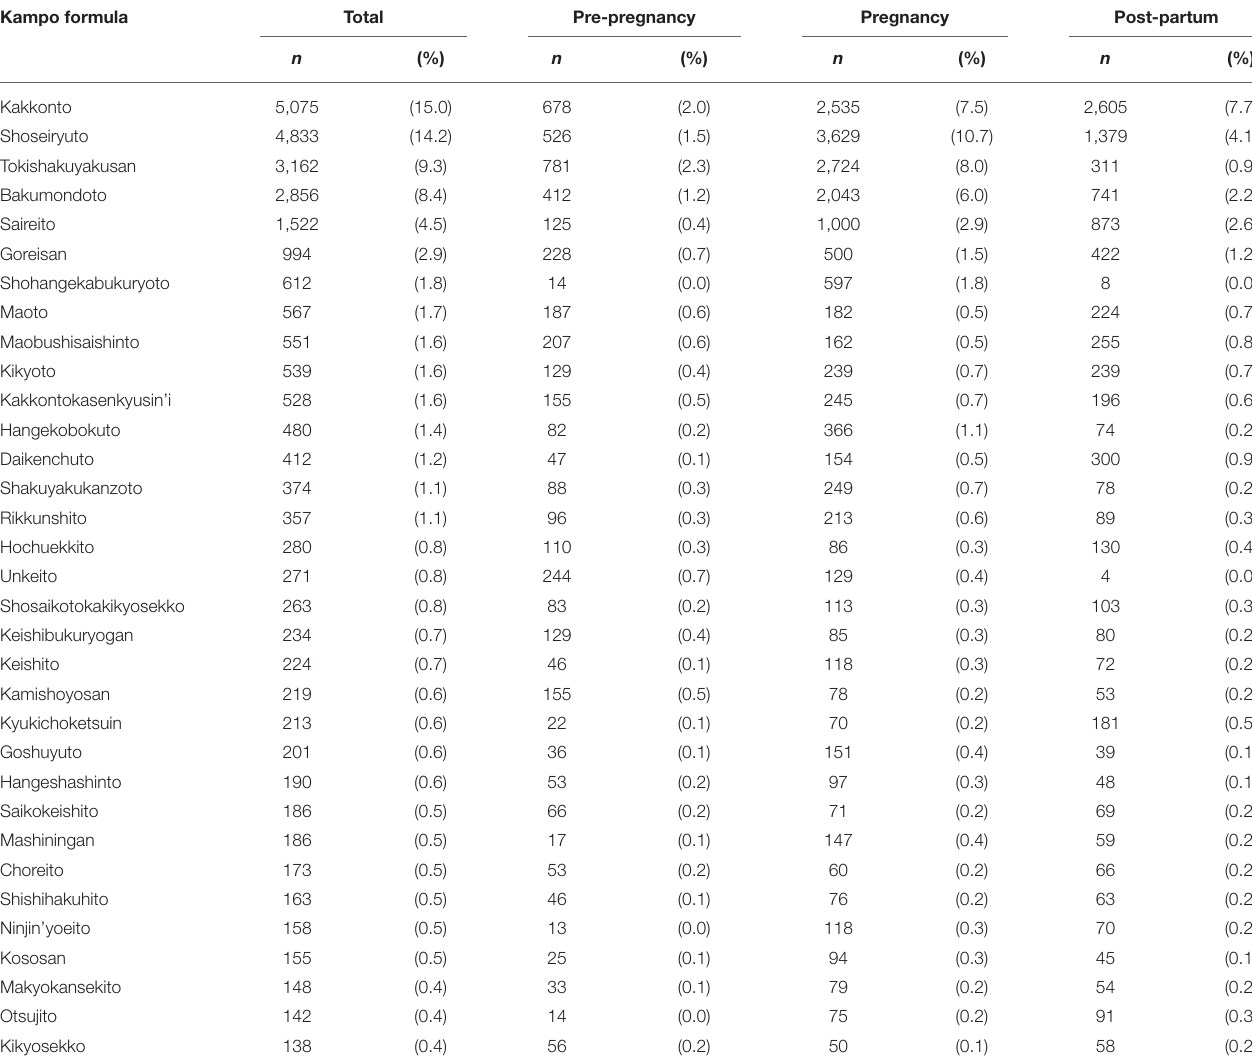
TABLE 1 | Kampo formulae with a prescription frequency of 0.4% or more. Kampo